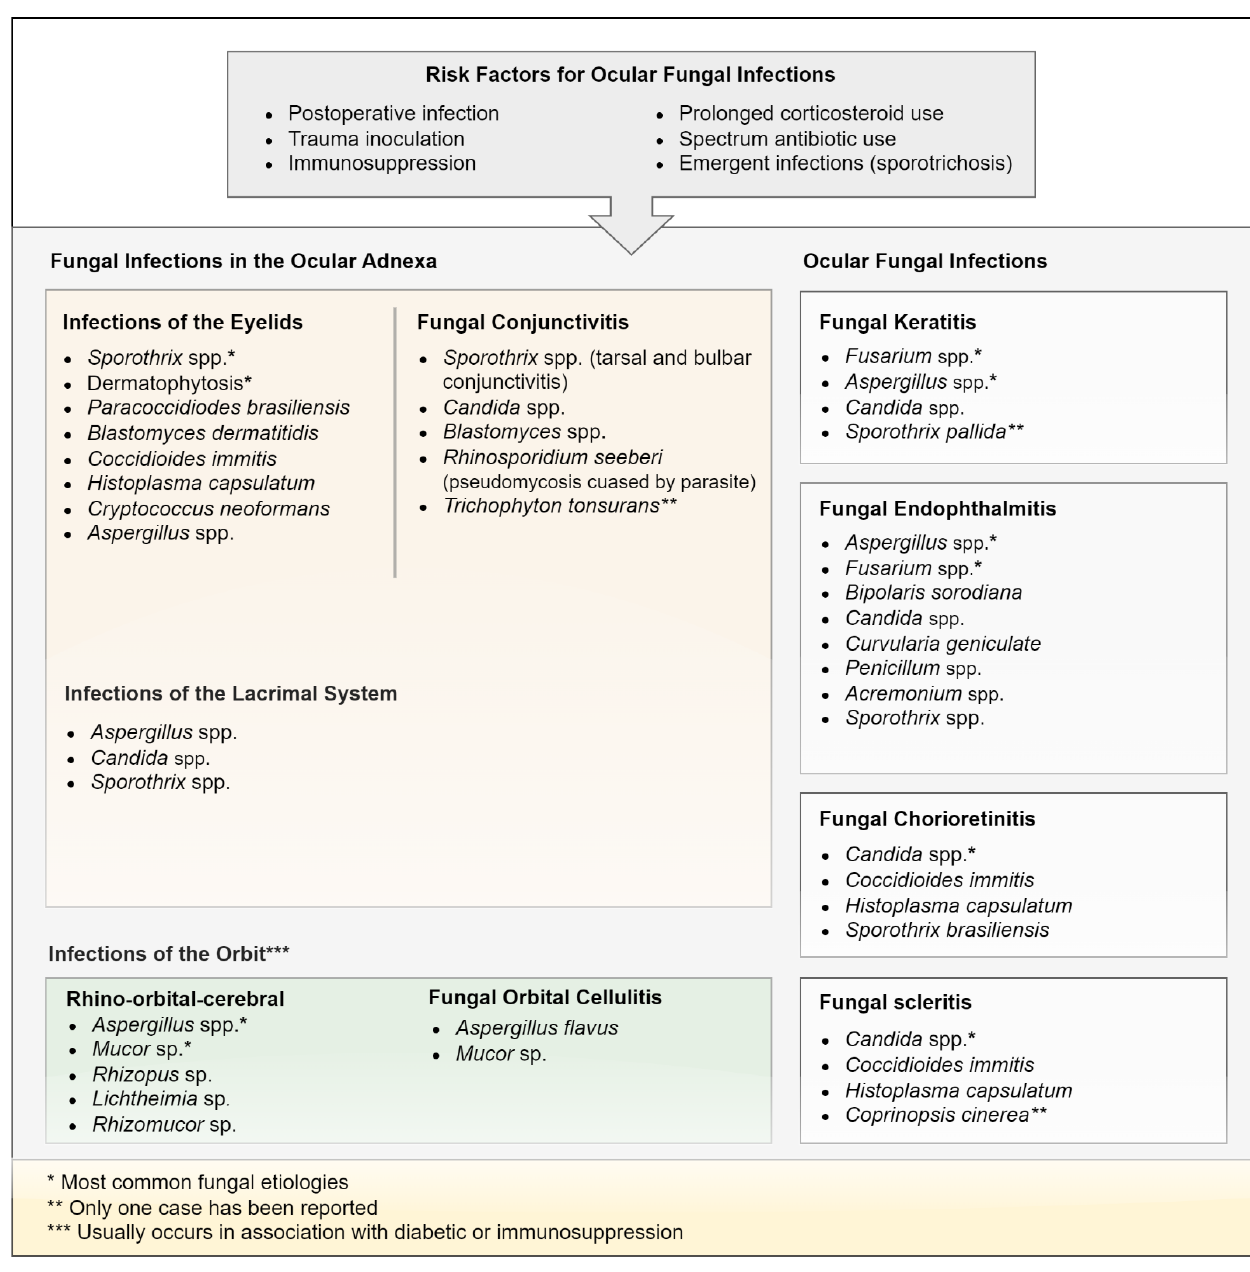
Figure 1. Causative aetiological agents from ocular fungal infections. Among fungal infections in the ocular adnexa, infection of the lacrimal sac and orbital fungal infection are uncommon causes of inflammation [16]. Infections of the lacrimal system include dacryoadenitis, canaliculitis and dacryocystitis. They are caused by primary endogenous infection or by organisms ascending to the lacrimal system [3]. Orbital fungal infections most commonly originate from adjacent paranasal sinuses, but they can result from other local or distant infection sources. They can be subdivided into preseptal infec- tions and postseptal infections, usually called orbital cellulitis [3] (Figure 1). In this special issue of the journal, a review describes the epidemiological findings, clinical, diagnosis, and treatment of ocular sporotrichosis, a subcutaneous mycosis, which can occasionally result in an ocular condition [18]. The findings reveal that between infections in the ocular adnexa, palpebral sporotrichosis is the most common clinical manifestation followed by conjunctivitis and dacryocystitis. These infections usually occur in hyperendemic areas